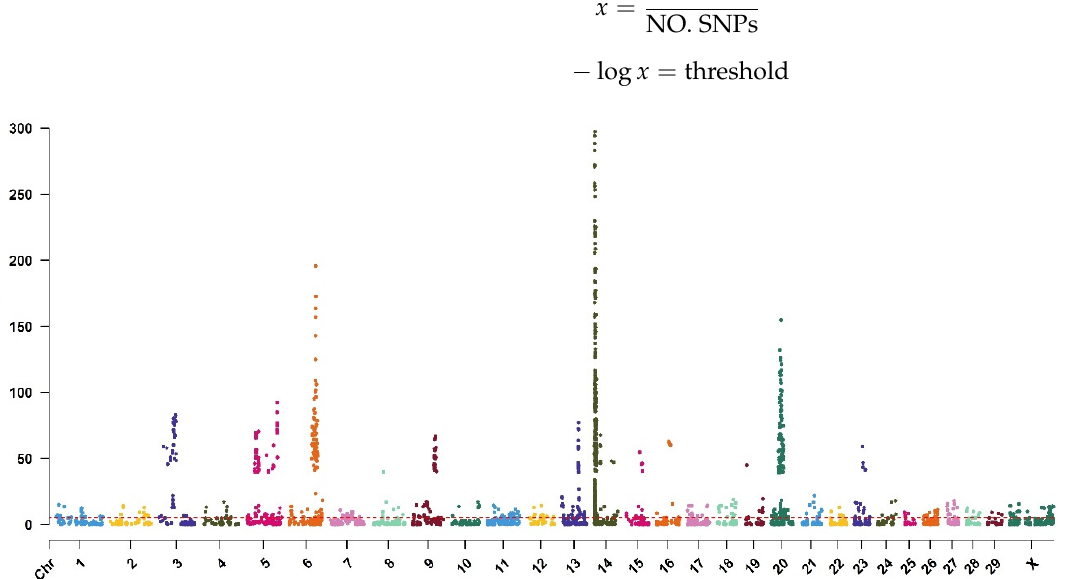
Figure 2. Manhattan plot of the GWAS meta-analysis for milk yield. Red line indicates p = 2.5 × 10 − 6 . Using the Ensembl site (http://ftp.ensembl.org/pub/release-103/gtf/bos_taurus/, accessed on 20 August 2020), the calculated data were checked and the loci of the effective markers and the genes were identified.